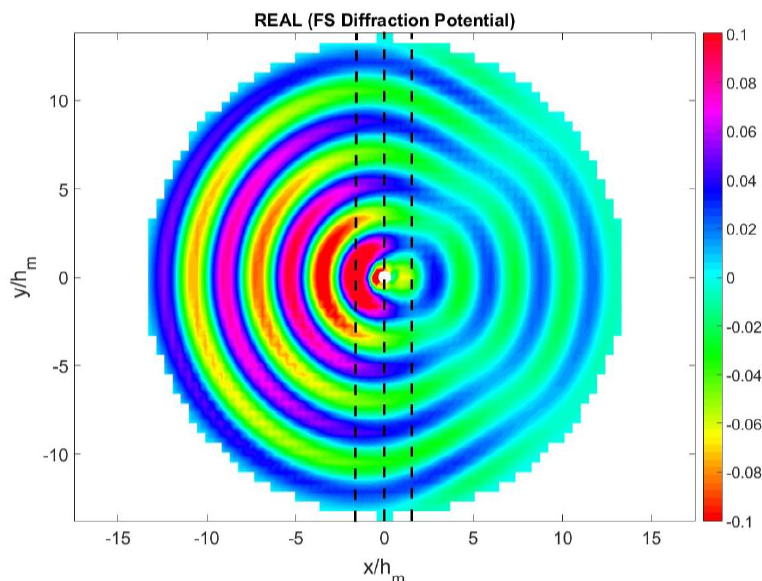
Figure 5. Diffraction field (real part) on the free surface for normally incident waves ω 7.0 ga / 0.7 a g , θ = 0 degrees as calculated by the present hybrid BEM over the variable bottom topography ( h 1 = 1.5 m, h 3 = 0.5 m, α bot = 0.5). The bottom contours are indicated by using dashed lines.